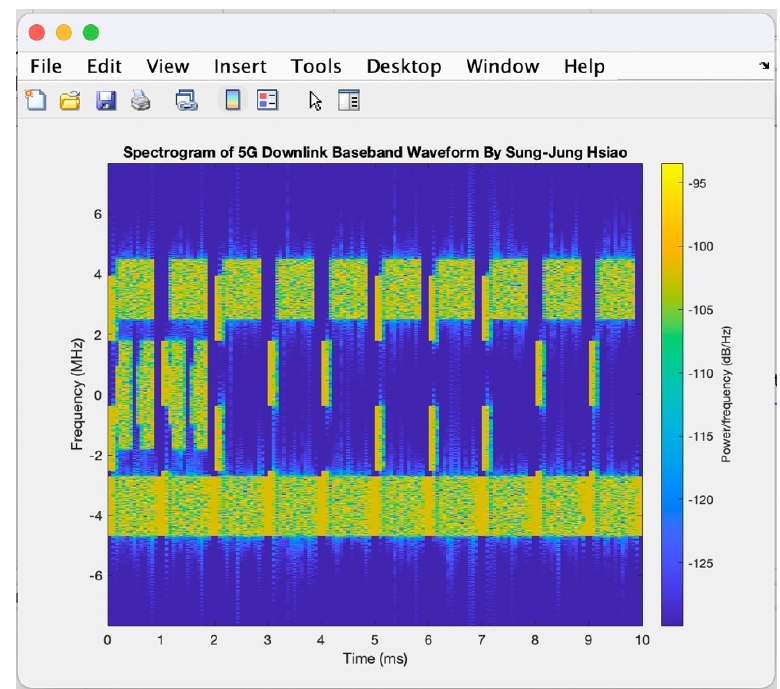
Figure A7. PRB values 40 to 50 and OFDM symbols 2 to 10.